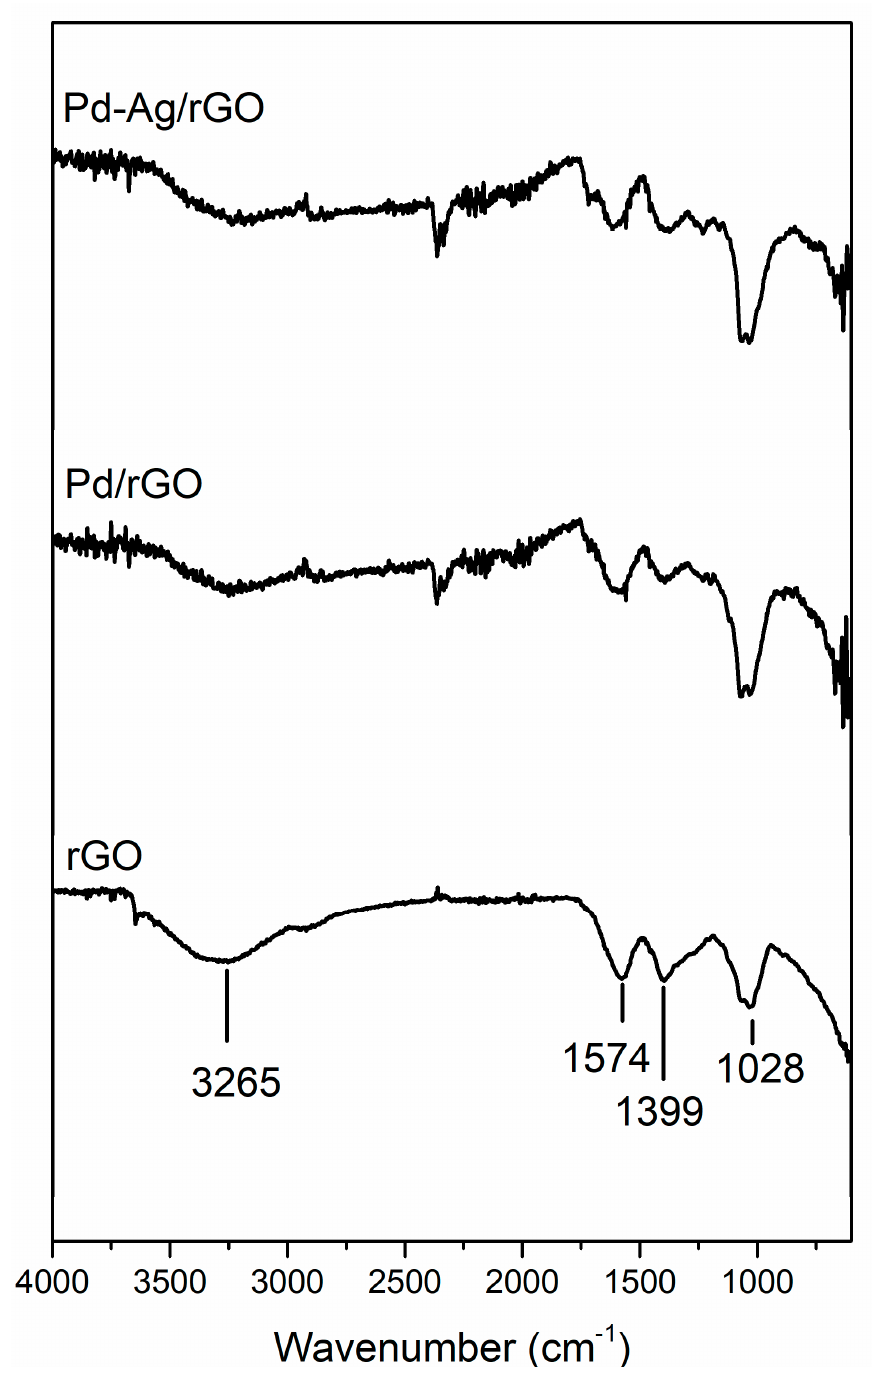
Figure 3. Fourier Transform Infrared (FTIR) spectra of fabricated GO, Pd/rGO, and Pd-Ag/rGO nanostructures using stevia leaf extract.